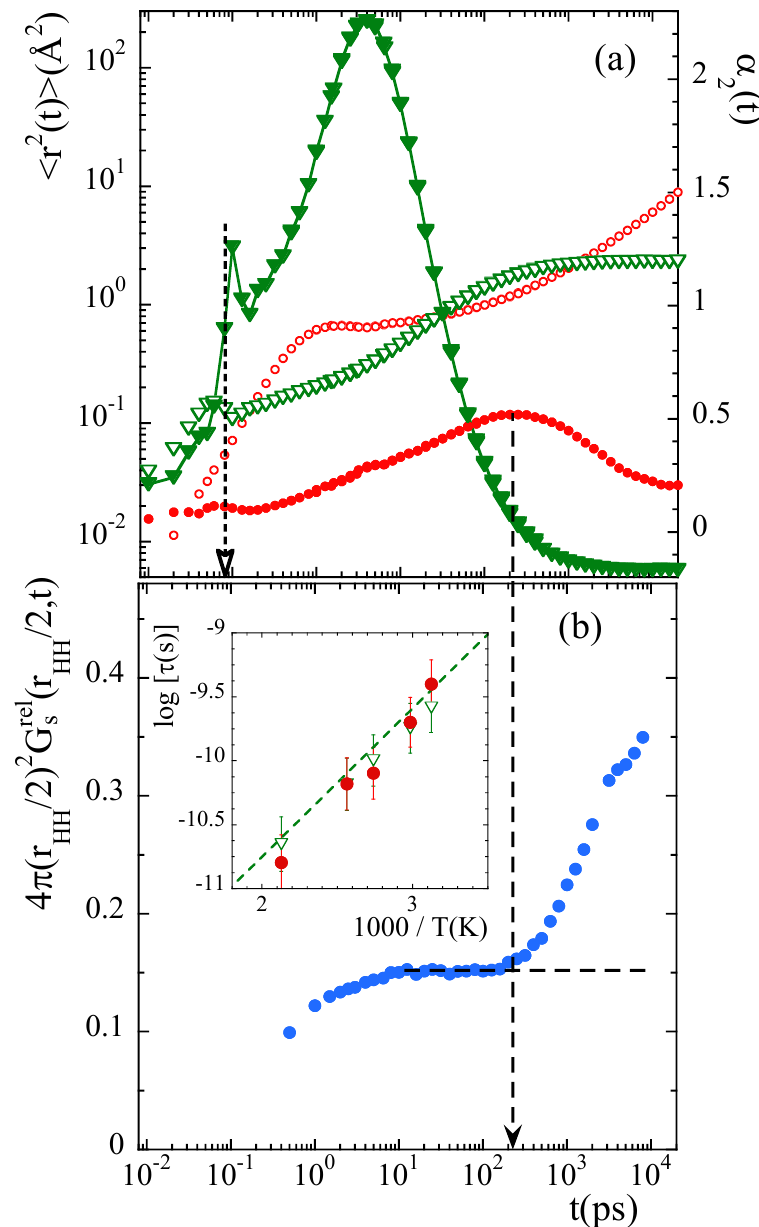
Figure 11. ( a ) Mean squared displacement (empty symbols) and non-Gaussian parameter (filled symbols) of main-chain carbons (circles) and relative motions of methyl-group hydrogens with respect to the methyl-group carbon (triangles). Vertical dotted arrow marks the value of τ ∞ in Equation (17). ( b ): Time dependence of the value of the function 4 π r 2 G rel s ( r , t ) evaluated at r = r HH /2. The horizontal dashed line shows the expected asymptotic behavior in the stationary state of rotations, and the vertical dashed arrow the time at which the data depart from such a behavior. All results correspond to 335 K. Insert: Arrhenius plot compiling the average residence time for methyl-group rotational motions τ o (empty triangles), the characteristic time for the maximum of the non-Gaussian R parameter t (cid:63) corresponding to main-chain carbons (filled circles) and the δ -process reported from NMR [36] and ESR [37] investigations (dashed